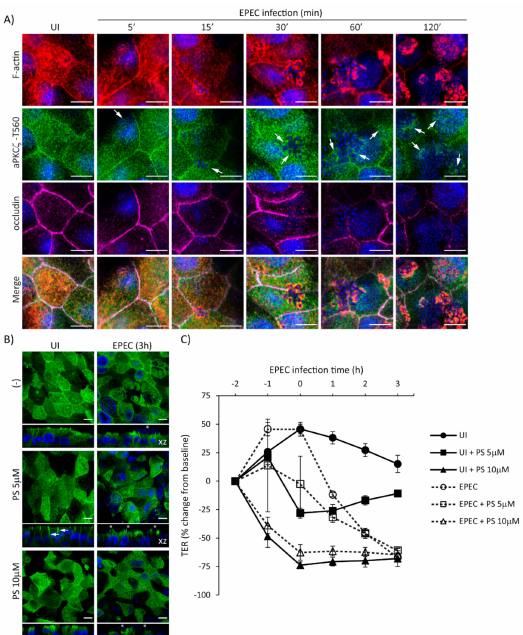
Figure 6. EPEC induces the recruitment of p-aPKC ζ –T560 to actin pedestals prior to redistribution of occludin from cell borders. ( A ) SKCO-15 cells were plated on Transwells and infected or not (UI) with EPEC for 5–120 min. Immunofluorescence microscopy for F-actin, p-aPKC ζ –T560, and occludin was performed. p-aPKC ζ –T560 is recruited to pedestals co-localizing with actin consistently as early as 15 min and increases as infection progresses. Occludin localization is not displaced from cell borders until 1–2 h post-infection. Arrows indicate the presence of p-aPKC ζ –T560 within EPEC pedestals. Scale bars, 10 µ m. ( B and C ) SKCO-15 cells were plated on Transwells and pre-incubated or not with aPKC ζ pseudosubstrate (PS) for 1 h prior to EPEC infection. Immunofluorescence of p-aPKC ζ –T410 was performed and TER was measured. ( B ) Treatment with PS redistributes p-aPKC ζ –T410 from the apical membrane and intercellular junctions to the lateral membrane (arrows) and cytoplasm without altering recruitment to EPEC pedestals (stars). Scale bars, 10 µ m. ( C ) Inhibition of aPKC ζ results in rapid disruption of barrier function in both UI and EPEC-infected